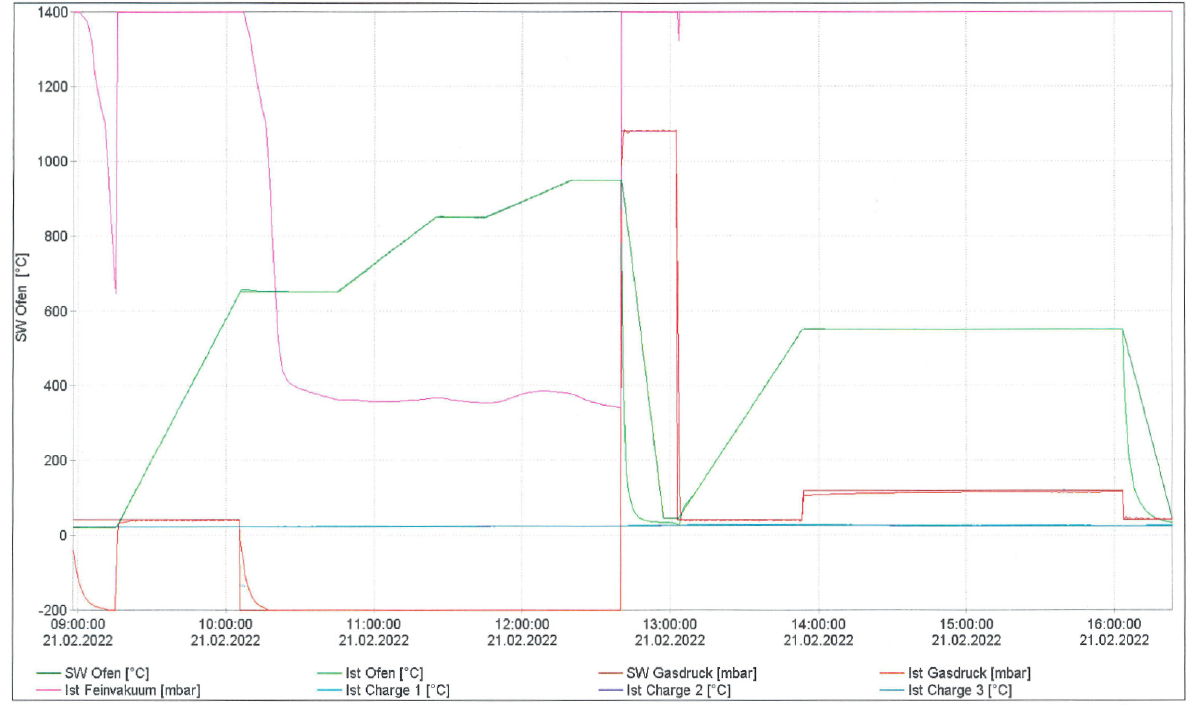
Figure 3. Heating diagram of the heat-treatment process (green—programmed and measured tem- perature, purple—vacuum, red—nitrogen pressure).